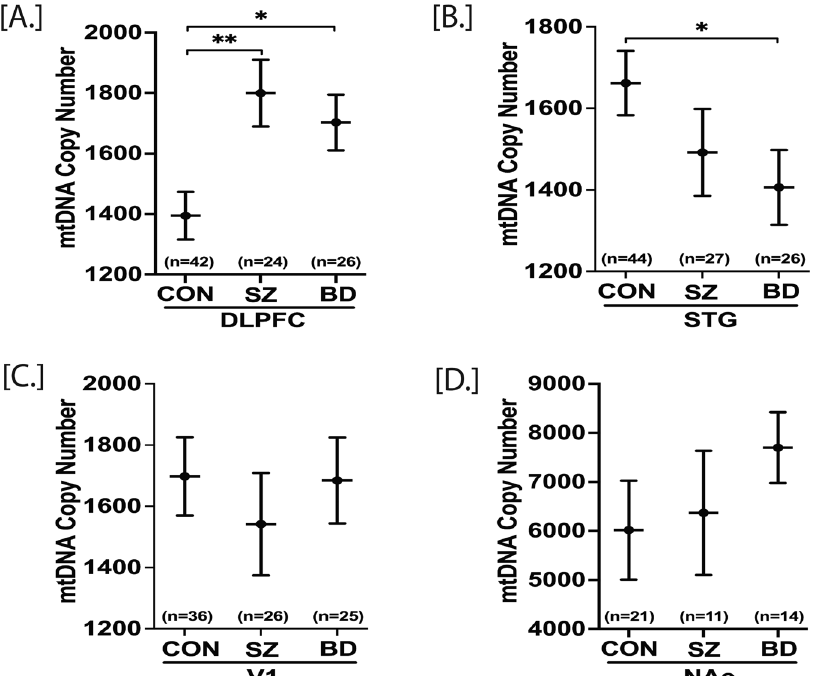
Fig. 1 mtDNA copy number in postmortem DLPFC, STG, V1 and NAc of control (CON), schizophrenia (SZ) and bipolar disorder (BD) groups. mtDNA copy number (CN) for DLPFC, STG and NAc were obtained through qPCR while V1 mtDNA copy number (CN) was obtained through ddPCR. mtDNA CN of a sample was calculated as mtDNA CN/ALB CN. A repeated measure analysis was performed for statistical signi fi cance with adjustment of age and sex for the DLPFC and STG together, whereas V1 and NAc data were analyzed individually. DLPFC mtDNA CN was signi fi cantly higher in both SZ and BD compared to control group ( A ). In STG, BD group had signi fi cantly lower mtDNA CN compared to control ( B ). In V1 and NAc, there were no signi fi cant groups differences ( C , D ). All data are represented as least square mean (LSM) ± Std. error. p < 0.05 and p < 0.01 are denoted by * and **, respectively, otherwise p >